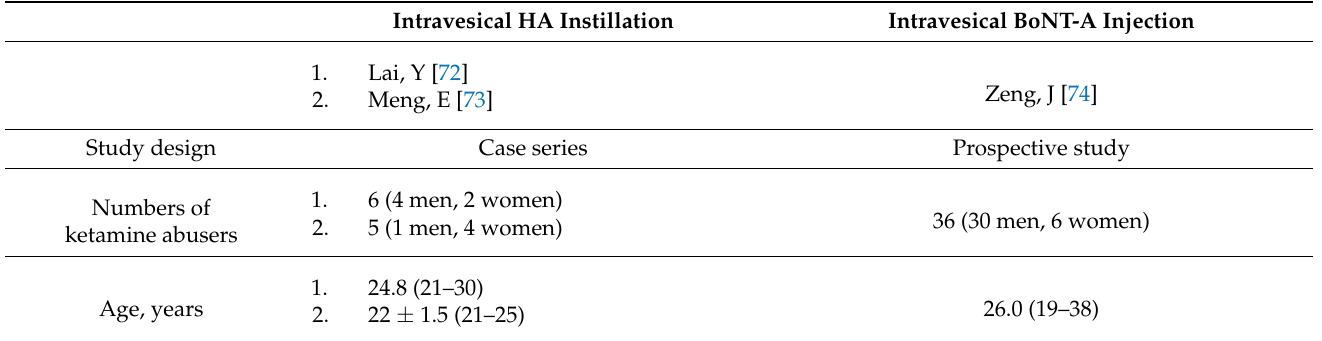
Table 2. Current therapies used for KC patients and their outcomes.